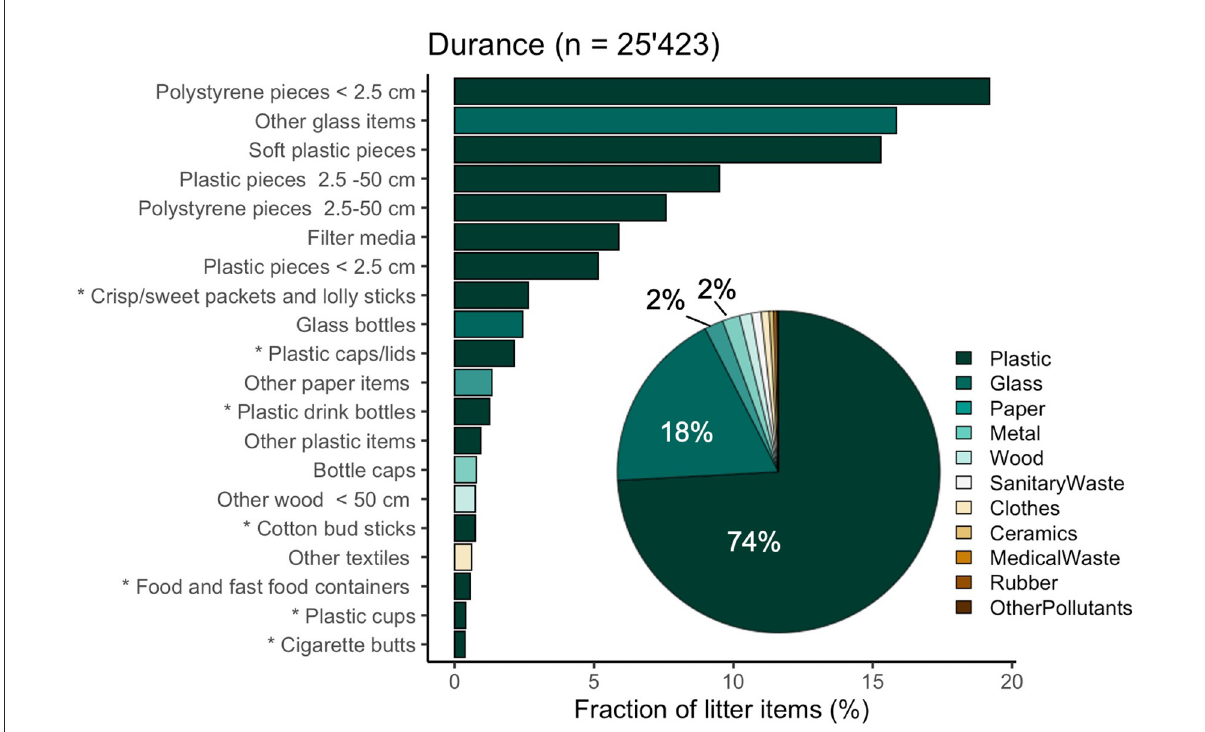
FIGURE3 Top litter items and materials on Durance’s riverbank and on Lake Serre-Ponçon’s beach. Top 20 litter items are shown as fraction of the total. Percentages < 2% are not